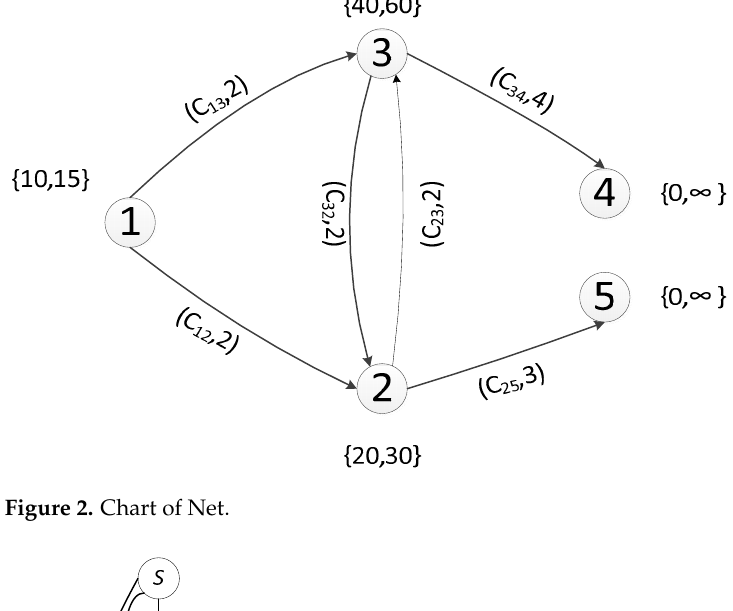
Figure 2. Chart of Net.